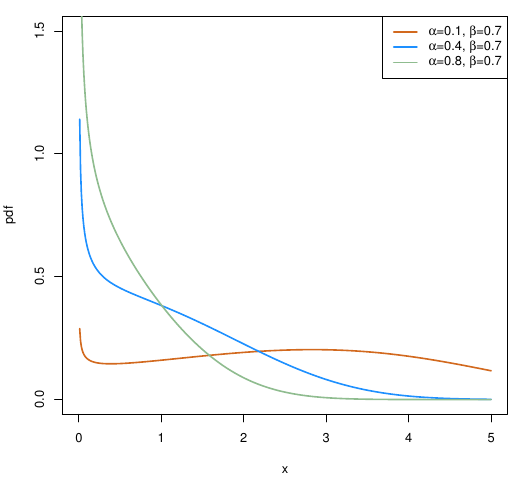
Figure 1. The pdf when 0 < α < 1, 0 < β < 1.